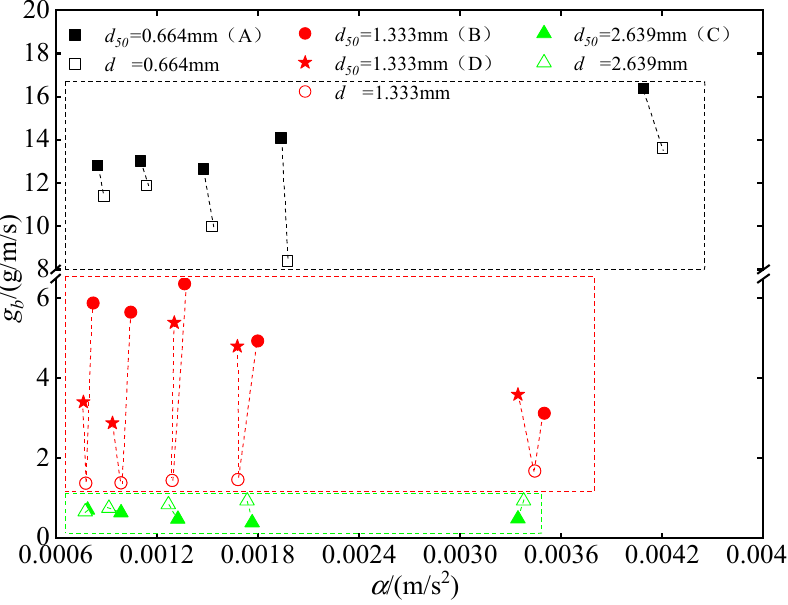
Figure 12. Comparison of non-uniform sand and uniform sand transport rate of the same median diameter under unsteady flow.